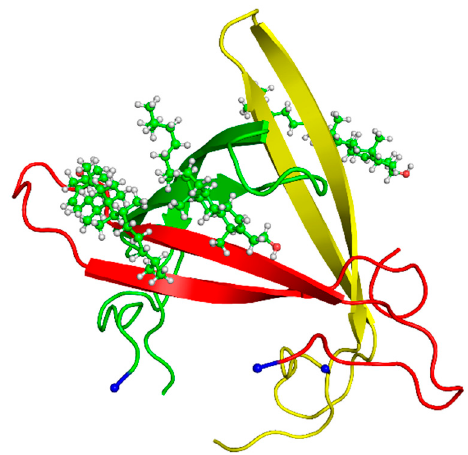
Figure 1 . Initial REST2 conformation of A β 42 trimer—three cholesterols with A β 42 forming β - sheets at residues 13–21 and 29–35 of chain A (red), residues 16–22 and 31–37 of chain B (green) and residues 13–21 and 27–35 of chain C (yellow). Each N-terminus is shown by a blue ball. The three all-atom cholesterol molecules are shown in green.